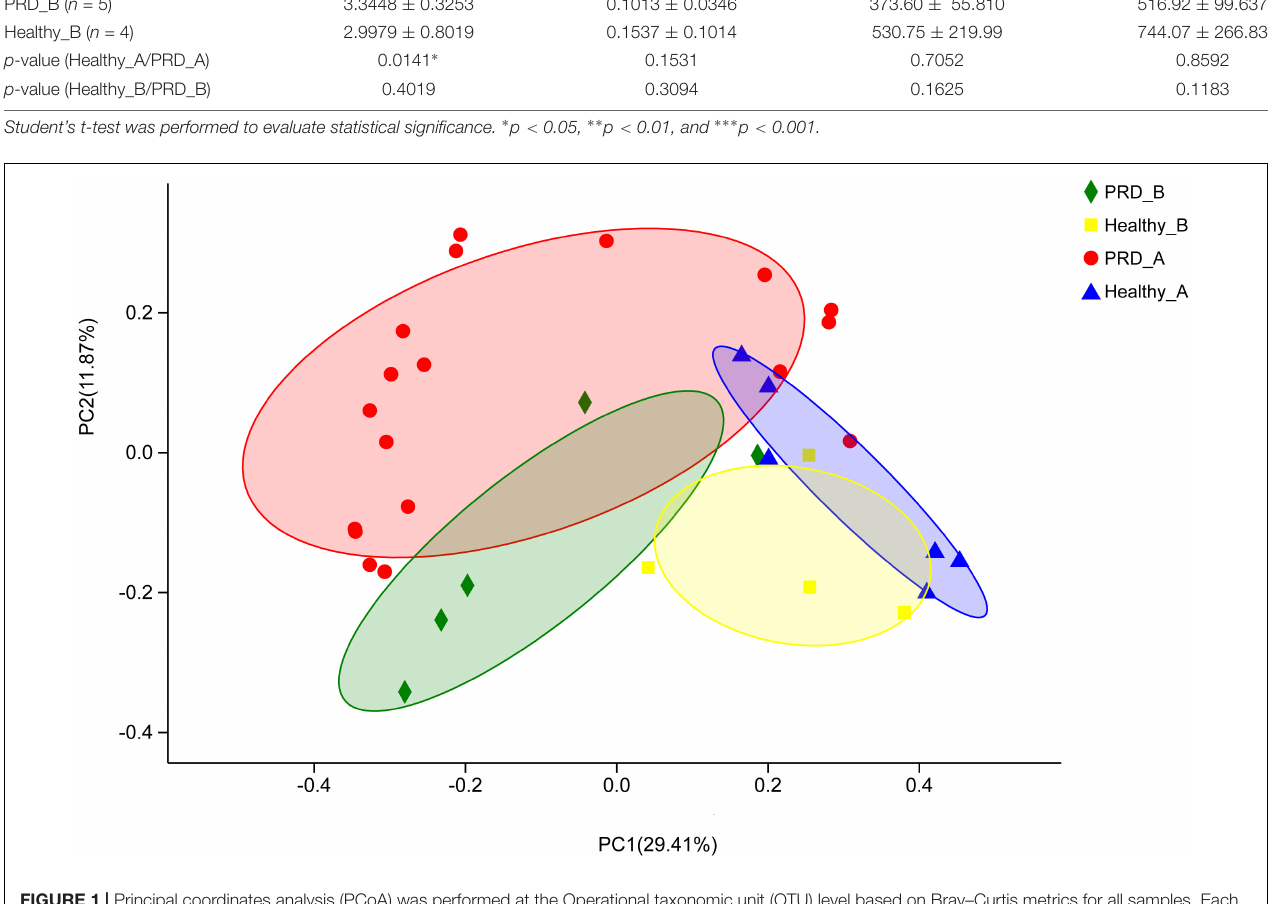
FIGURE 1 | Principal coordinates analysis (PCoA) was performed at the Operational taxonomic unit (OTU) level based on Bray–Curtis metrics for all samples. Each group is represented in a different color and